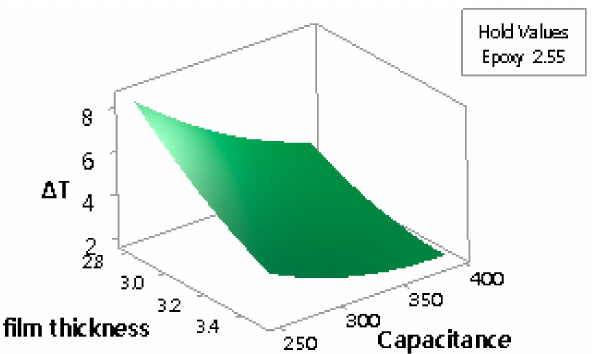
Figure 6. Response surface analysis results for (cid:52) T versus film thickness and capacitance.